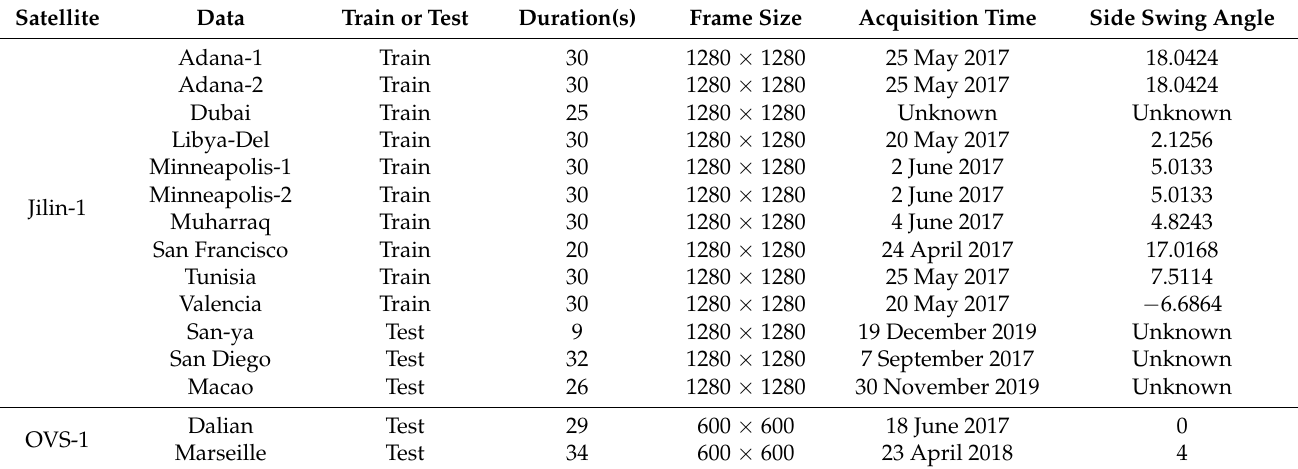
Table 1. Jilin-1 and OVS-1 data used in the